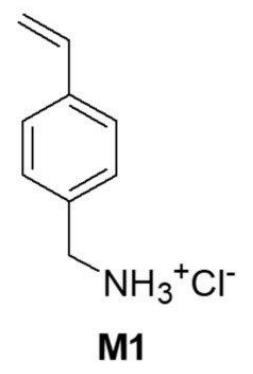
Figure 2. Chemical structure of the monomer M1.